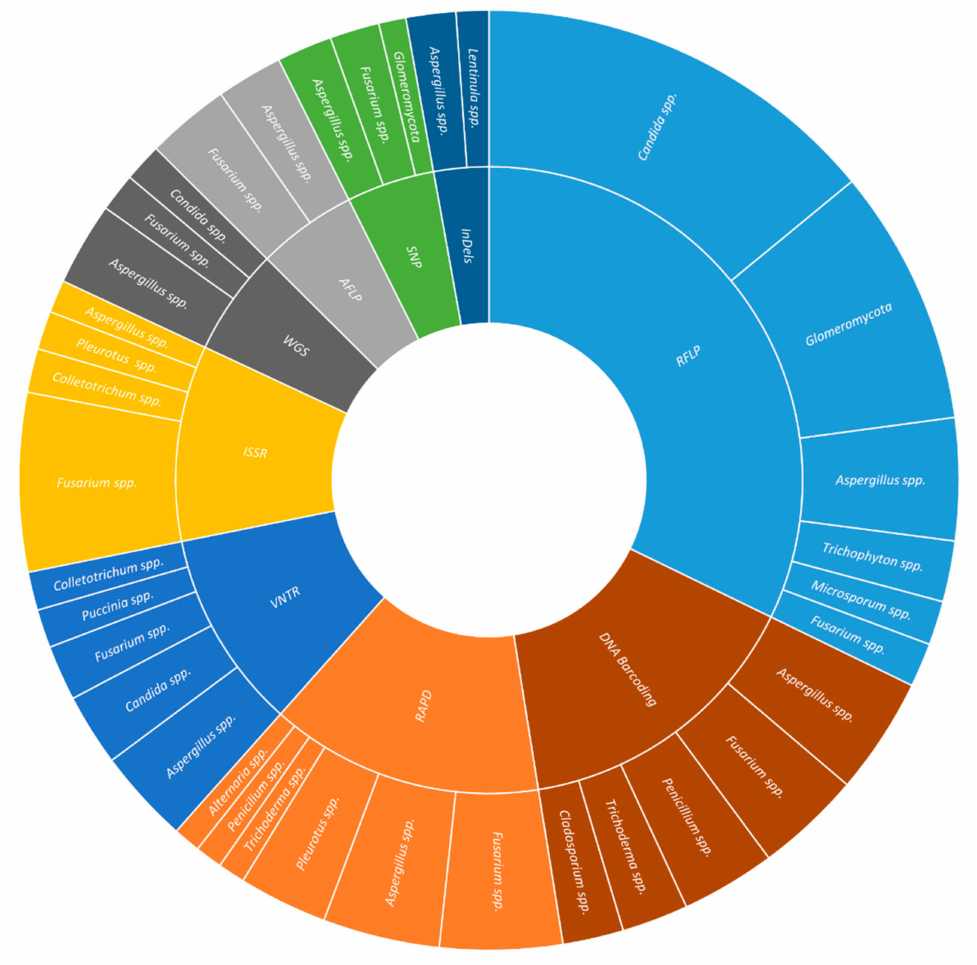
Figure 1. Distribution of the main fungal species according to the molecular markers used. The number of published articles for each molecular marker was normalized to allow a direct comparison between the different molecular markers (only normalized values higher than 1 are